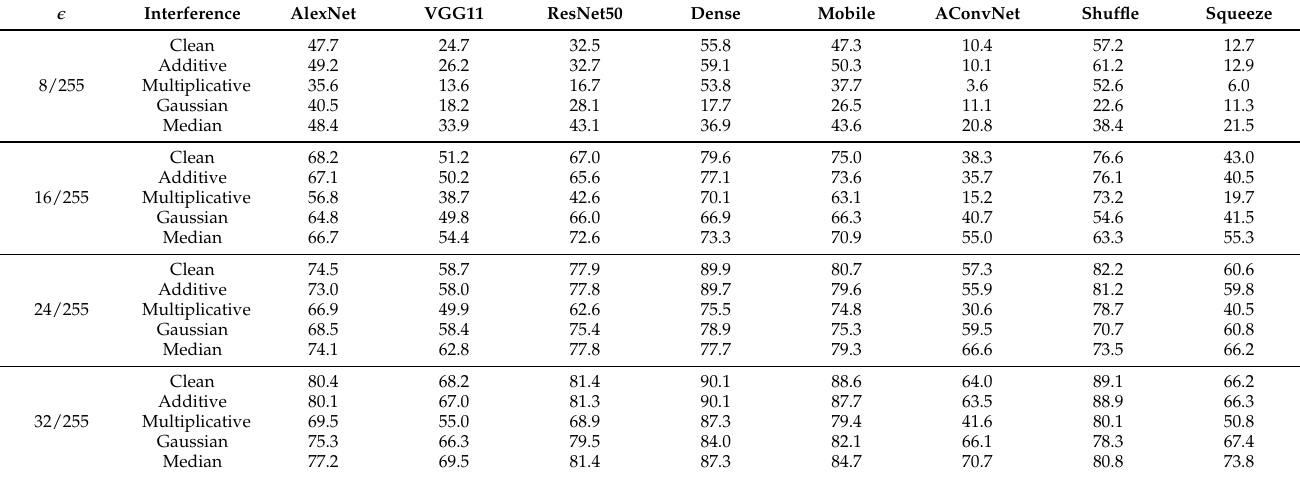
Table A3. Robustness test of DF-UAP with MobileNetV2 as substitute